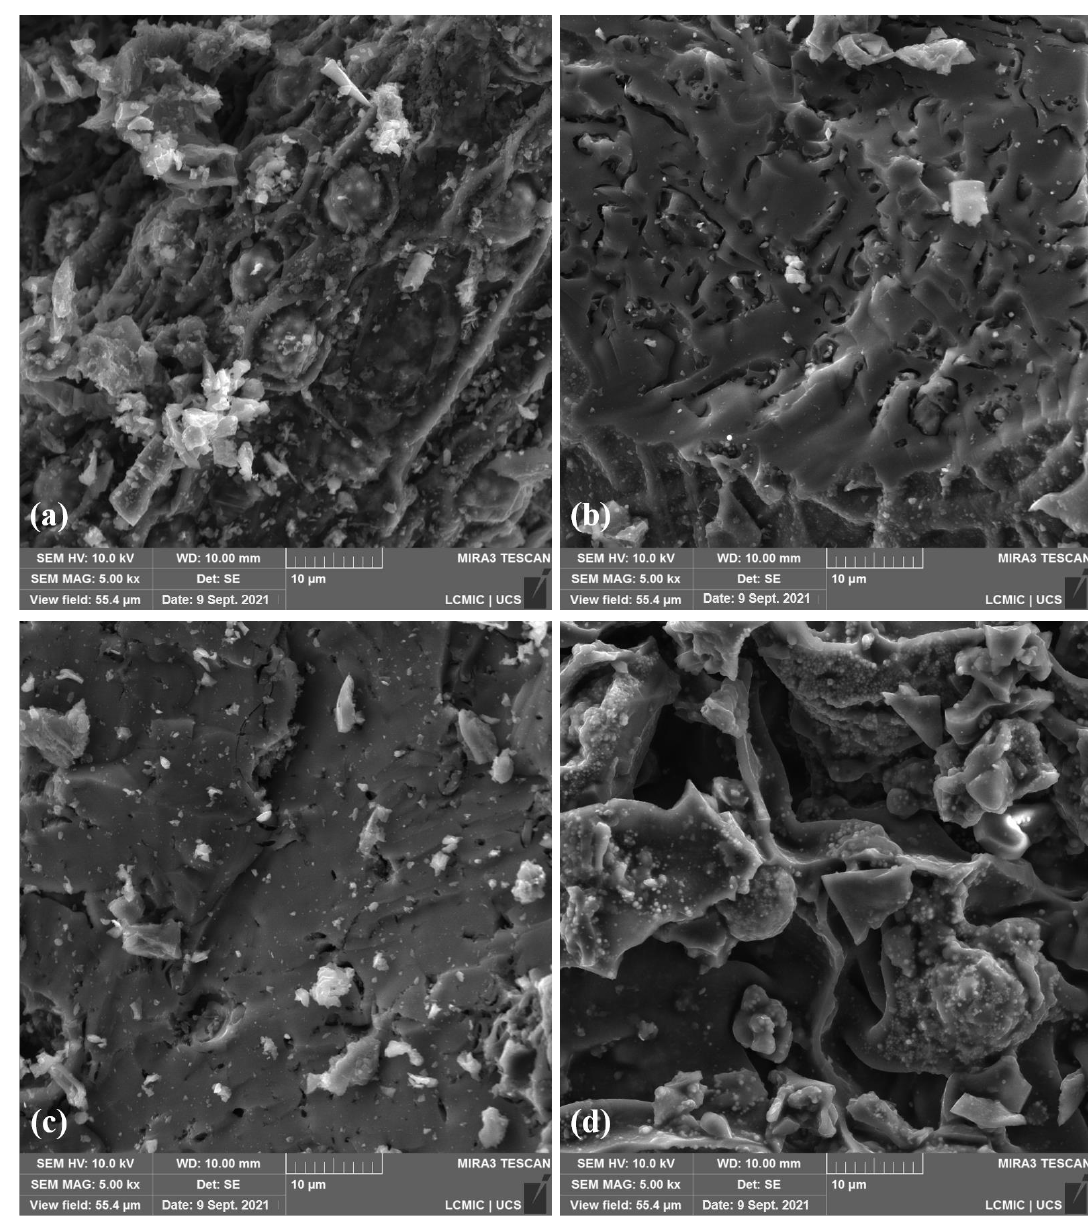
Figure 4. SEM micrographs of ( a ) FIB.700, ( b ) ALM.700, ( c ) END.700 and ( d ) DOA.700. N 2 sorption/desorption analysis was performed, and the isotherms are presented in Figure S6 (Supplementary Material). The BET and BJH results are presented in Table 2.